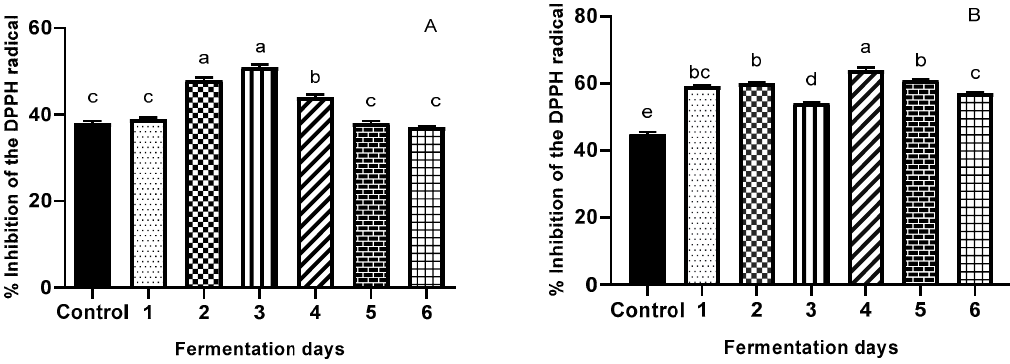
Figure 3. Antioxidant activity (DPPH free-radical-scavenging assay) ( A illustrating WB; B illustrating OB) of the extracts (control and fermented (6 days)). The percentage inhibition (I%) was calculated as [1 − (test sample absorbance / blank sample absorbance)] × 100. Values are expressed as mean values ± SD, I%, n = 3, and are followed by different letters (a–f) indicating significant differences ( p < 0.05) between days of fermentation (One-way ANOVA - Multiple comparison test -Tukey multiple range test ( p = 0.05)-GraphPad Prism Version 8.0.1, Graph Pad Software, Inc., San Diego, CA, USA).